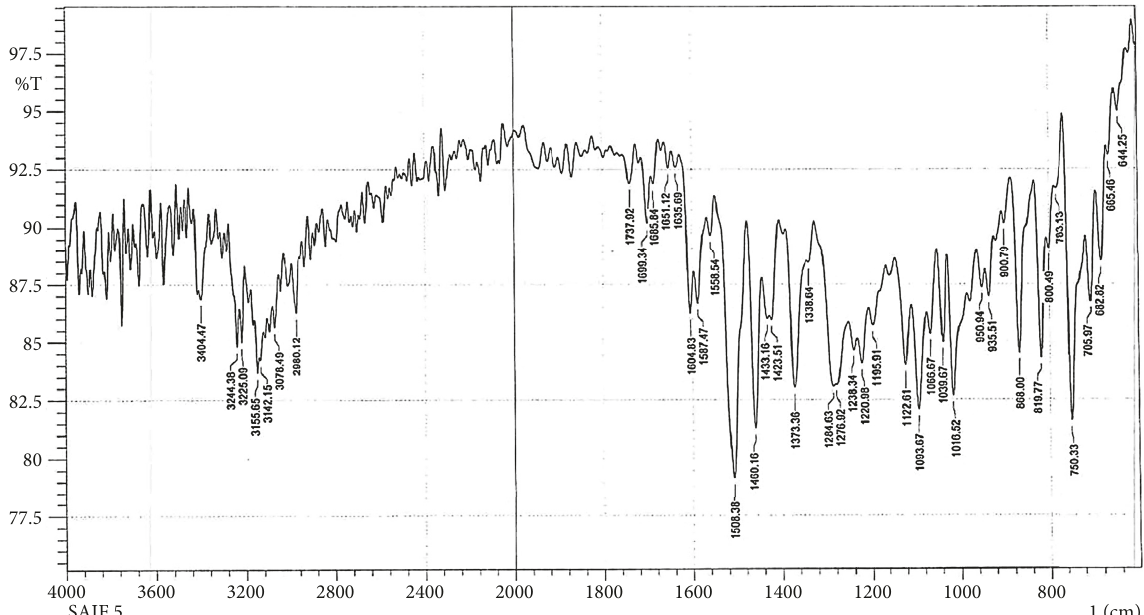
Figure 2: Fourier Transform Infrared Spectrum of